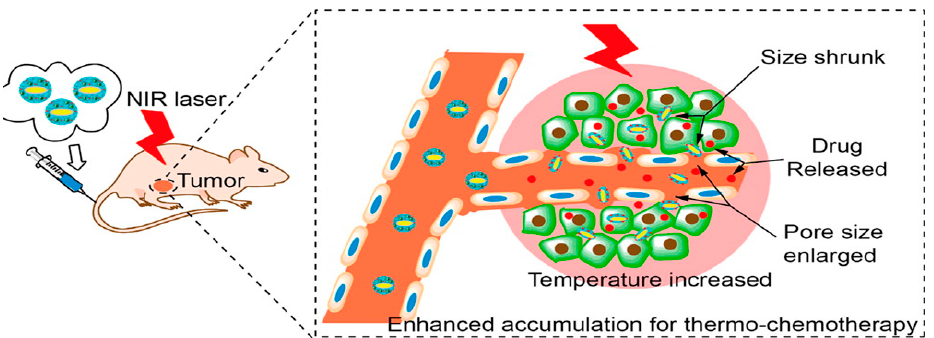
Figure 3. Image illustrating a Near InfraRed Laser being applied to the site of delivery and the mechanism of action that occurs with heat stimulus. Adapted with permission from Zhang et al. [52]. Copyright © 2014. American Chemical Society.